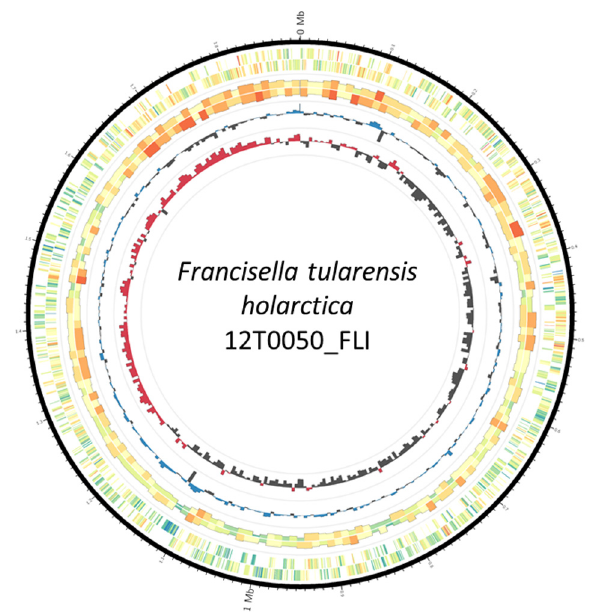
FIGURE 1 | Plot of the complete Francisella tularensis subsp. holarctica 12T0050. The genome consists of 1890738 base pairs and 2114 predicted coding sequences. The circles represent from the inside: 1, GC skew (red above and black below zero, 10 kb window); 2, GC content (blue above and black below genome average of 32.20%, 10 kb window); 3, strand-specific genome-wide methylation analyzed in 10 kb windows; 4, strand-specific methylation per gene; 5, scale in million base pairs (Mb). Methylation color spectrum goes from blue (minimum, 5%) over yellow (mean, 12.5%) to red (maximum,